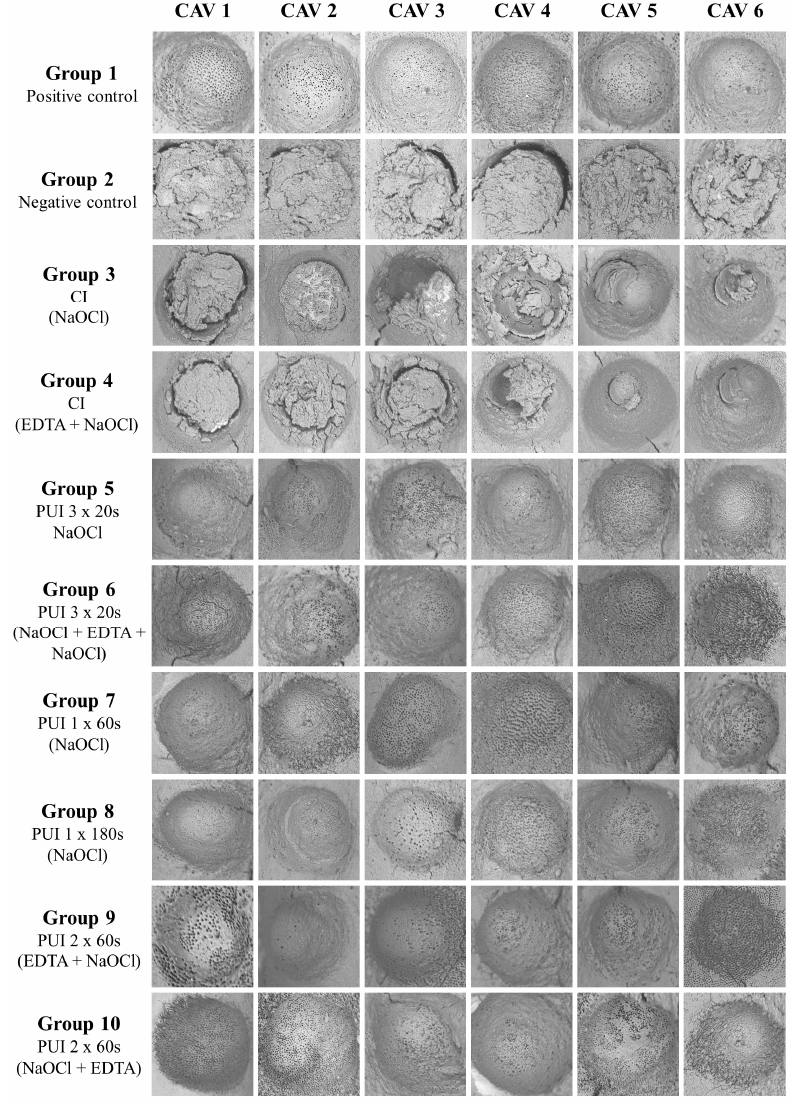
Figure 2. Representative images of each group in 500× magnification in the Scanning Electron Mi- croscope of low vacuum. Microscope of low